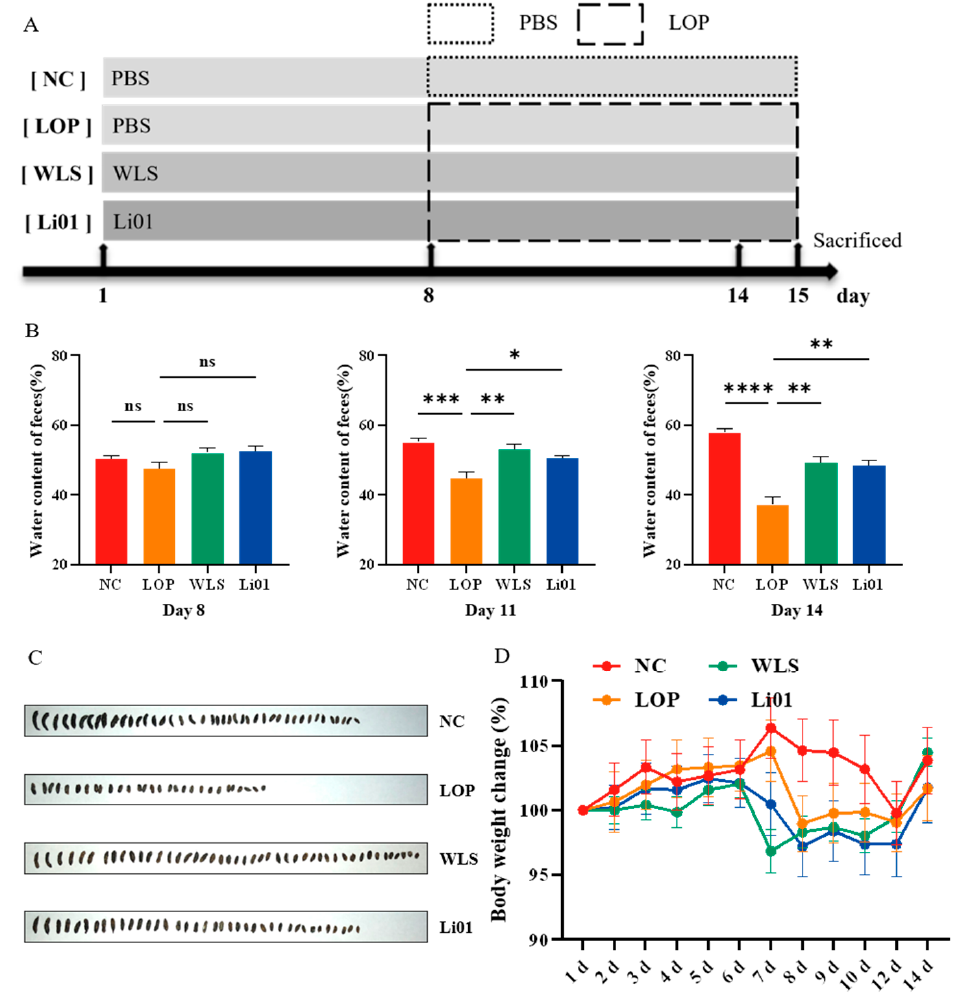
Figure 1. Changes in fecal characteristics and body weight in mice with loperamide-induced consti- pation (LOP) after treatment with Ligilactobacillus salivarius Li01 (Li01), Weileshu probiotic (WLS),